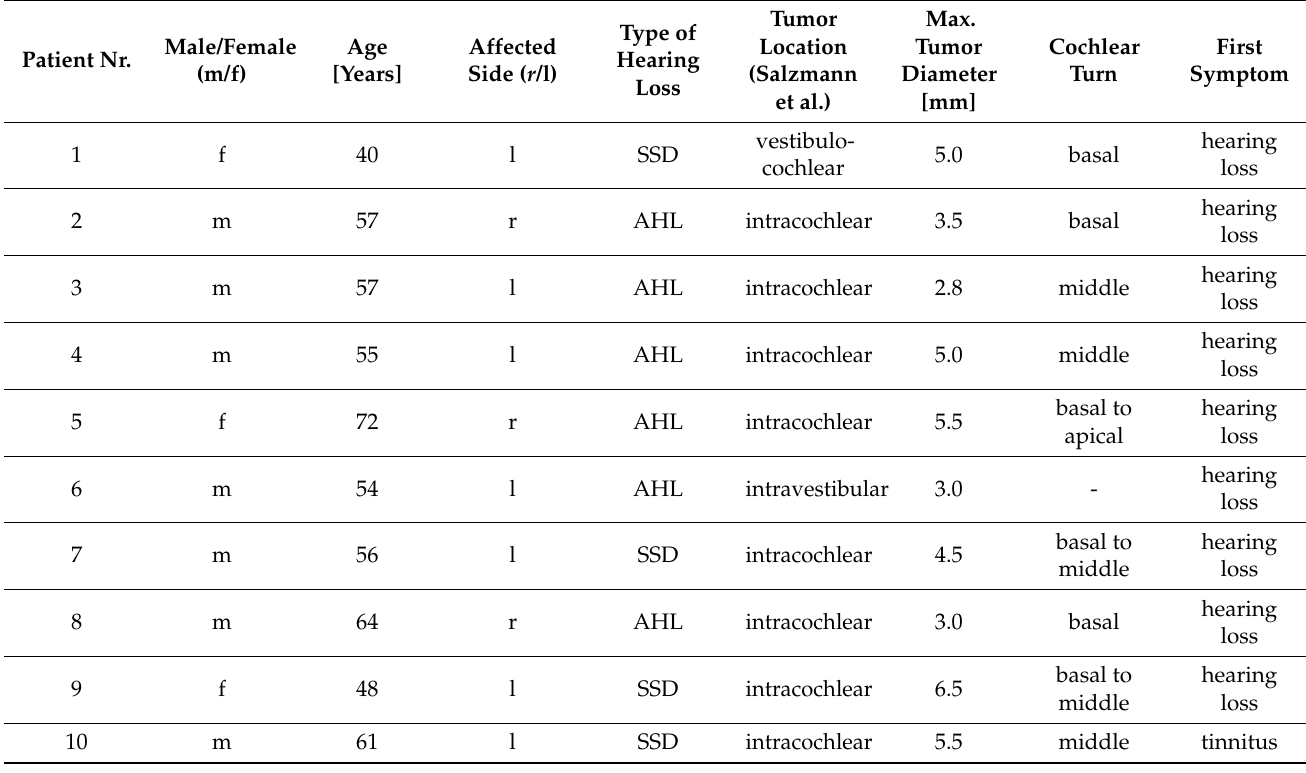
Table 1. Patients characteristics. r = right, l = left; SSD = single sided deafness, AHL = asymmetric hearing loss, DSD = double-sided deafness.